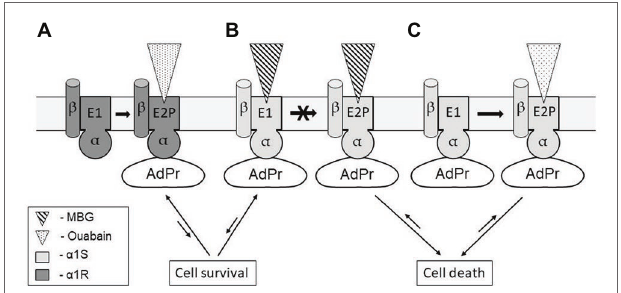
FIGURE 2 | Possible mechanisms representing the absence of cell death signaling due to ouabain binding to α 1R-NKA (A) ; and the appearance of this signaling with distinct potency as result of marinobufagenin (B) and ouabain binding to α 1S-NKA (C) . Conformational transition induced by ouabain binding to α 1R-NKA does not affect the binding of unidentified adaptor protein (AdPr) to NKA (A) . Marinobufagenin (MBG) with similar affinity freezes α 1S-NKA in conformations E1 and E2P (transition between them is prohibited), AdP is released from complex with E1-conformation providing cell survival and does not release from complex with E2P providing cell death (B,C) . For more details, see the